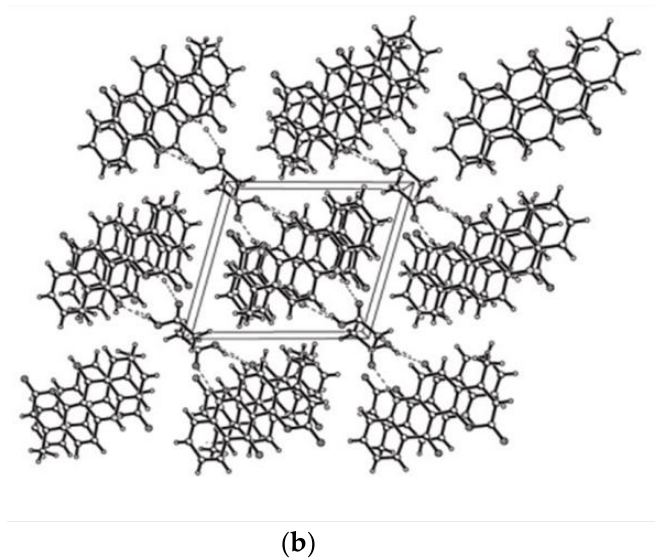
Figure 3. ( a ) X-ray crystal structure and ( b ) the packing of probe S, viewed down from a direction. Dashed lines indicate hydrogen bonds.